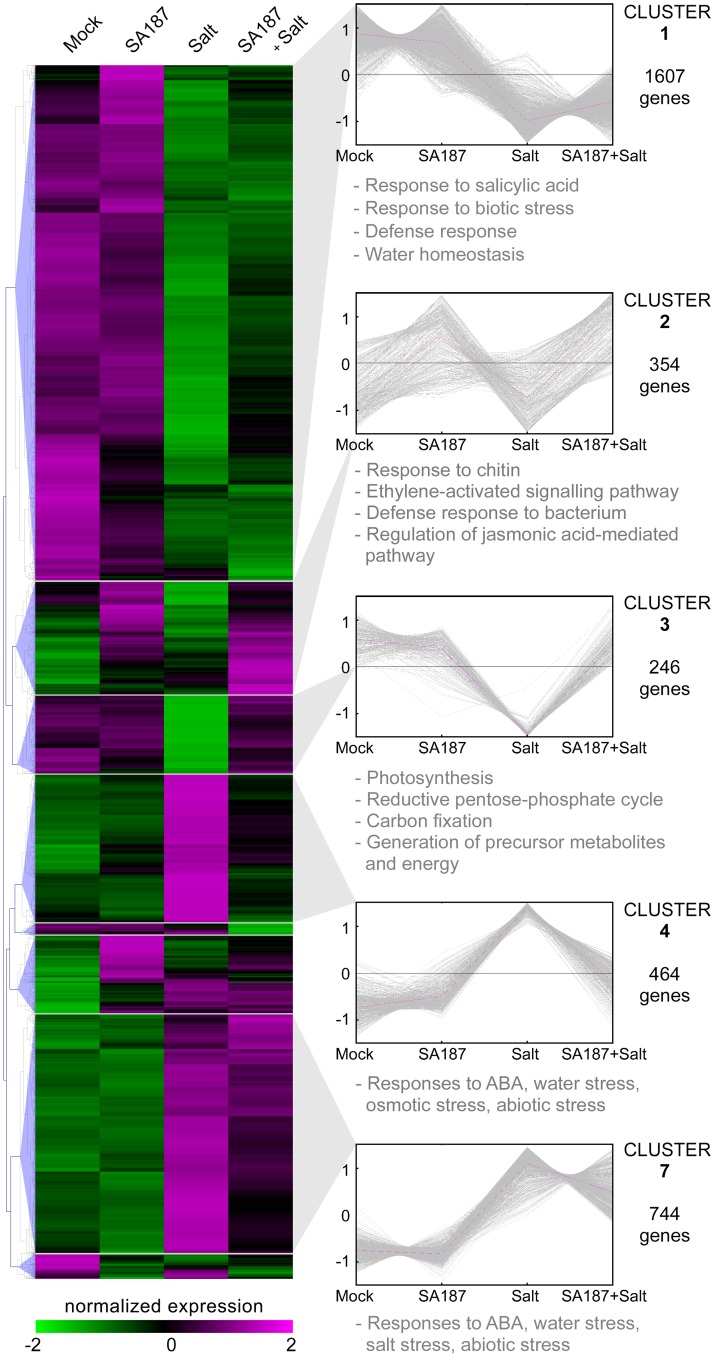
Transcriptome analysis of Arabidopsis response to SA187.Hierarchical clustering of up- and down-regulated genes in Arabidopsis seedlings in response to SA187, salt (100 mM NaCl) or both treatments based on the RNA-Seq analysis. For every gene, FPKM values were normalized. Heat map colors indicate expression levels. For the most relevant clusters, gene families significantly enriched are indicated based on gene ontology.